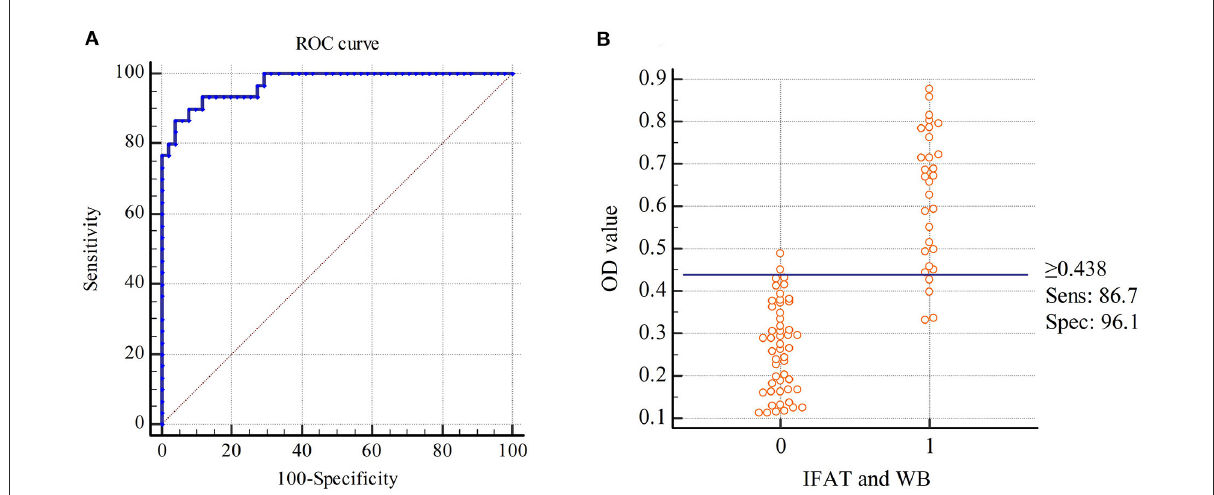
FIGURE3 Receiver Operating Characteristics (ROC) analysis for the indirect ELISA with chimeric protein rSRS2-SAG1-GRA7. (A) ROC plot. Area under curve = 0.971 (0.0155); 95% confidence interval between 0.908 and 0.996. (B) Frequency distribution of confirmed positive (1) and confirmed negative (0) sera. Samples were considered positive when cut-off values were ≥ 0.438 ELISA absorbance values.